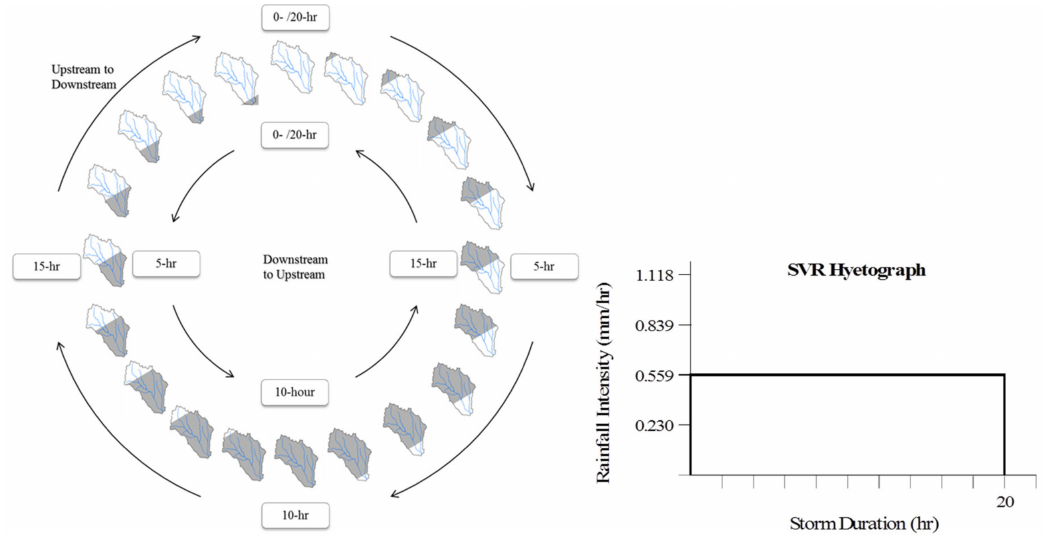
Figure 6. Spatially varied rainfall (SVR) applied to Cowleech Fork of the Sabine River, Texas.